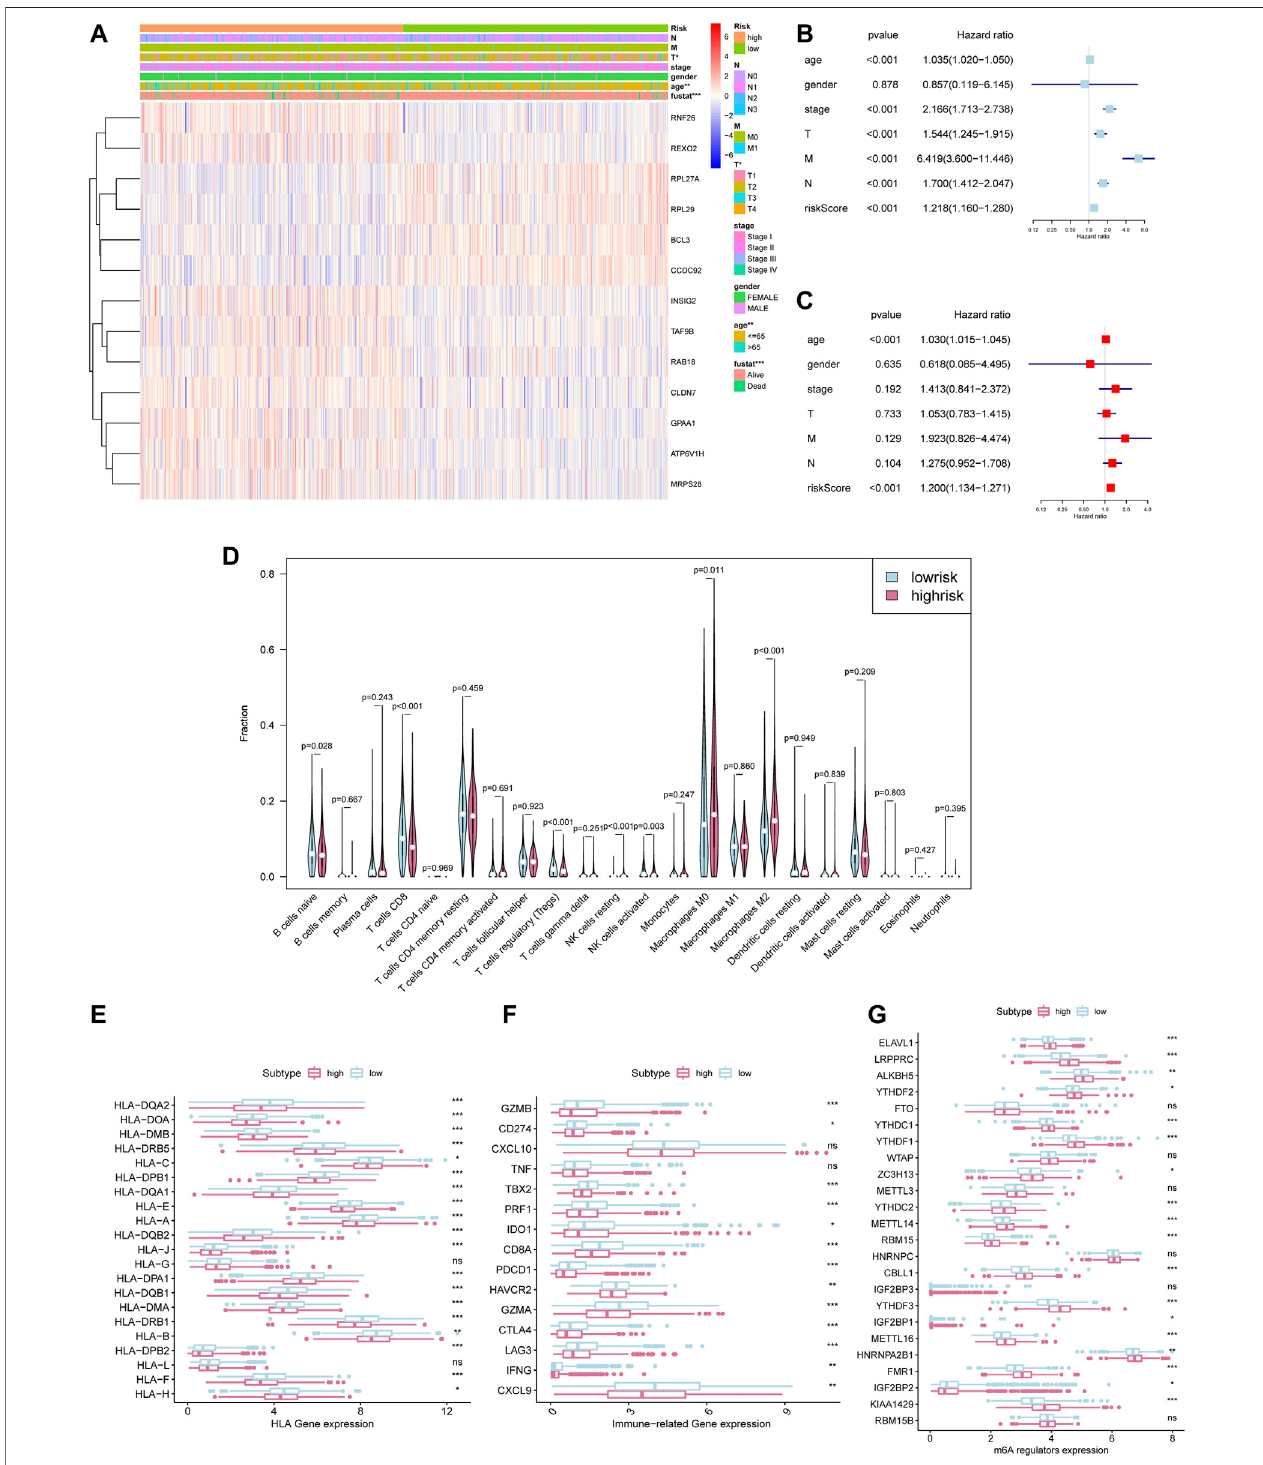
FIGURE 7 | Prognostic risk score indicated strong associations with pathological stage and tumor somatic mutation in breast cancer. * p < 0.05, ** p < 0.01 and *** p < 0.001. (A) The heatmap of 24 m6A regulators in high-m6aRiskscore and low-m6aRiskscore breast cancer. (B) Univariate Cox regression analysis to estimate the prognostic signi fi cance of clinicopathological factors and m6aRiskscore. (C) Multivariate Cox regression analysis to estimate the prognostic signi fi cance of clinicopathological factors and m6aRiskscore. (D) Different immune cell content in tumor tissue. The green represents the low-m6aRiskscore group and the red represents the high-m6aRiskscore group. (E) The expression level of HLA-related gene in the subgroups. (F) The expression level of immune-related gene in the subgroups. (G) The expression level of m6A regulators in the subgroups.